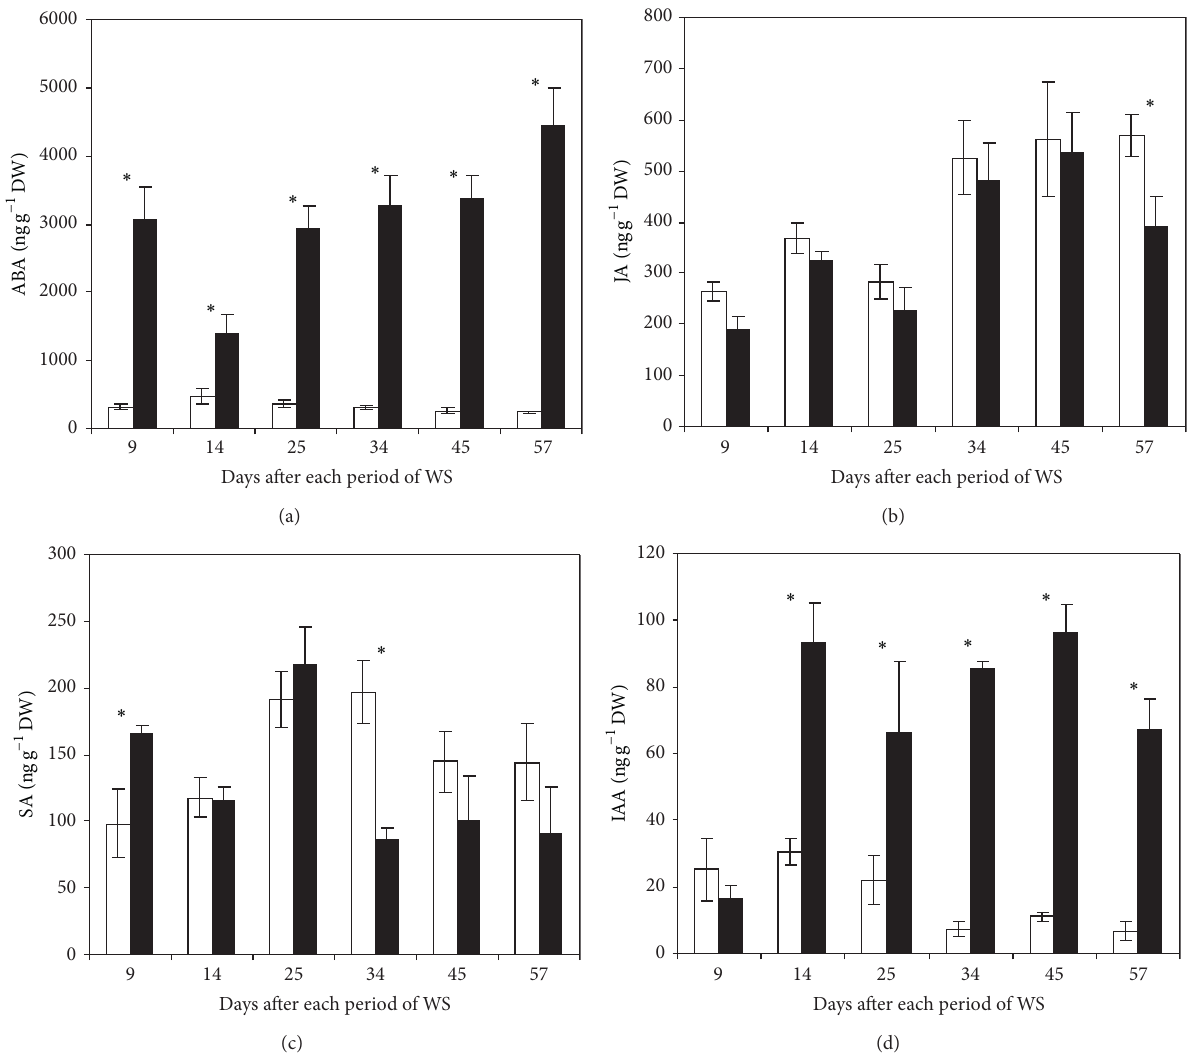
Figure 6: ABA (a), JA (b), SA (c), and IAA (d) concentrations in leaves from regularly irrigated ( ◻ ) and water-stressed ( ◼ ) banana plants. Data are means ± SE and each value was determined in three different plants with three replicates per treatment (𝑛 = 9) . Data were compared for each date using the least significant difference (LSD) test. Significant differences at 𝑃 ≤ 0.05 are represented by an asterisk ( ∗ ). WS: water